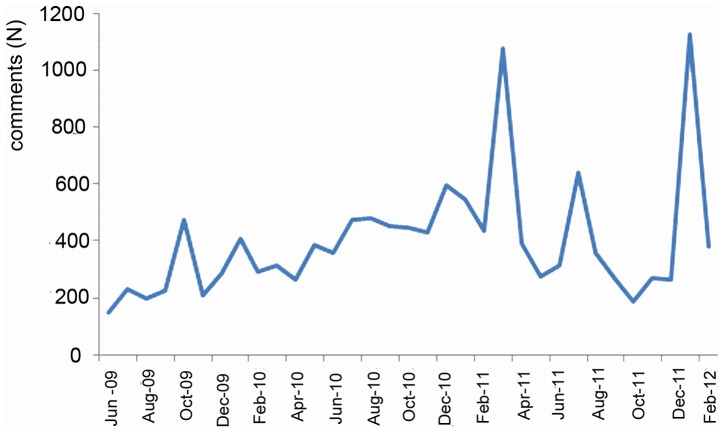
Number of comments made on a viral You Tube video. The relationship between number of comments and time; the two peaks coincide with the uploading of a second viral video of a slow loris holding a tiny cocktail umbrella and the production shortly thereafter of a slow loris conservation page on Wikipedia (March 2011) and the broadcasting of a BBC Natural World film on slow loris conservation, The Jungle Gremlins of Java (January 2012).